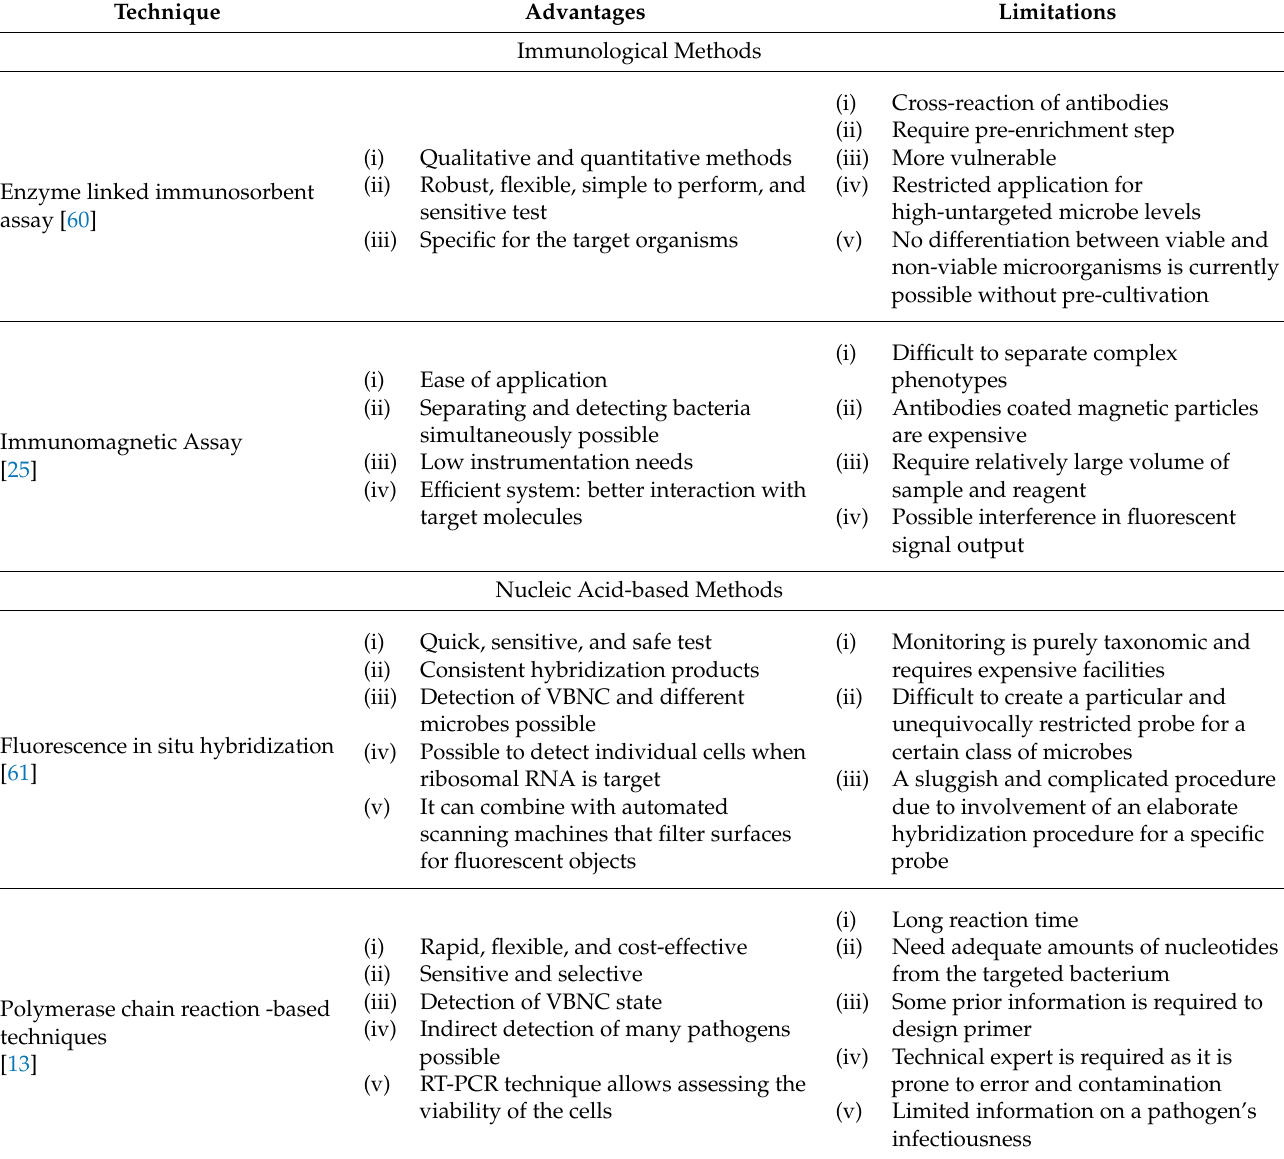
Table 2. Advantages and limitations of advanced techniques used for the detection of microbial pathogens in environmental